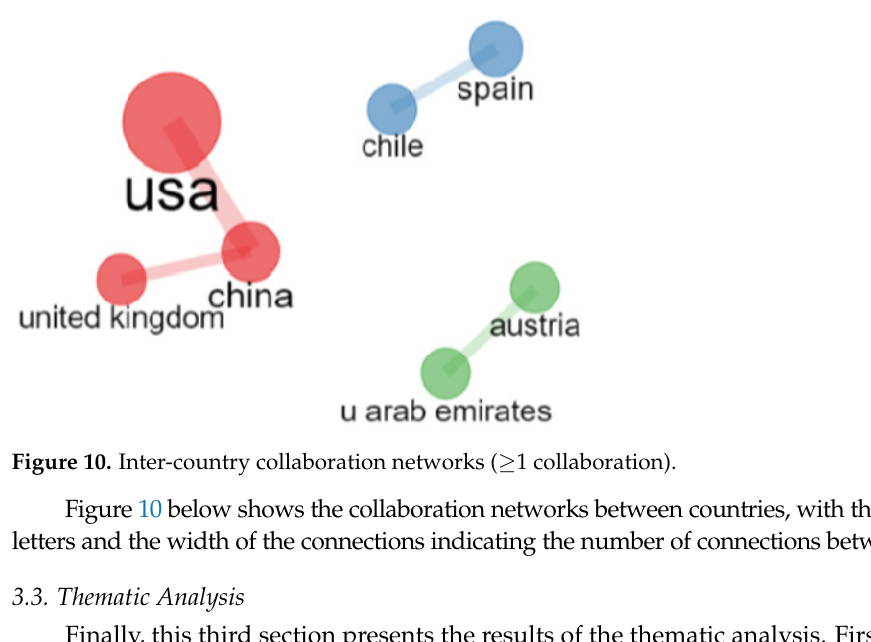
Figure 9. Inter-country collaboration networks map ( ≥ 1 collaboration).